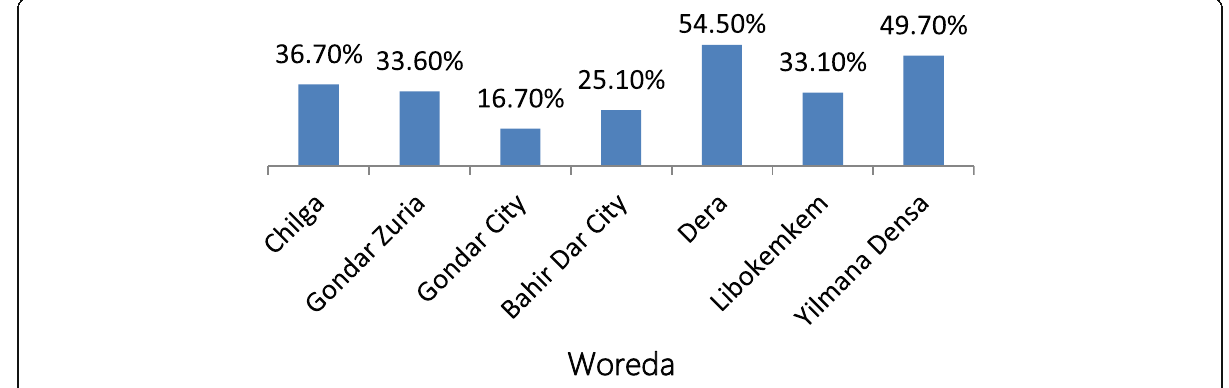
Fig. 1 Prevalence of early marriage in Western Amhara, Ethiopia (Survey,